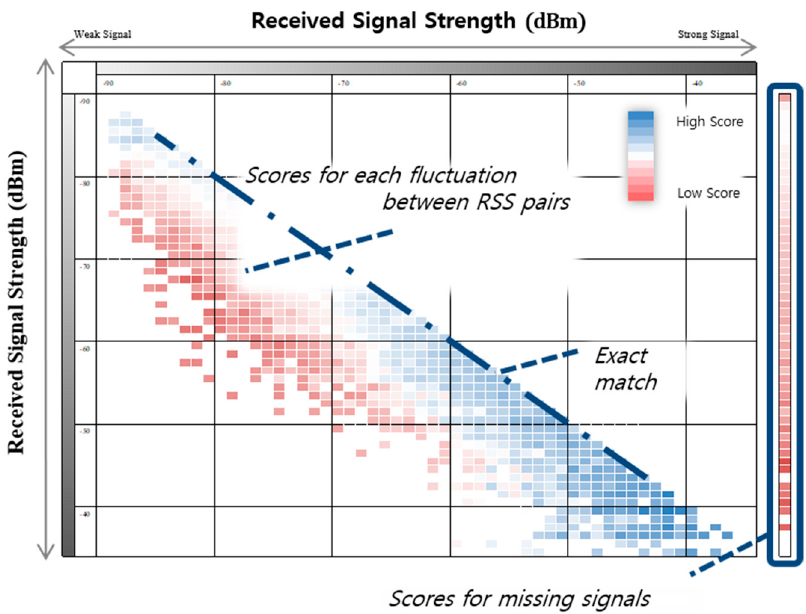
Figure 6. Example of a signal fluctuation matrix (SFM).